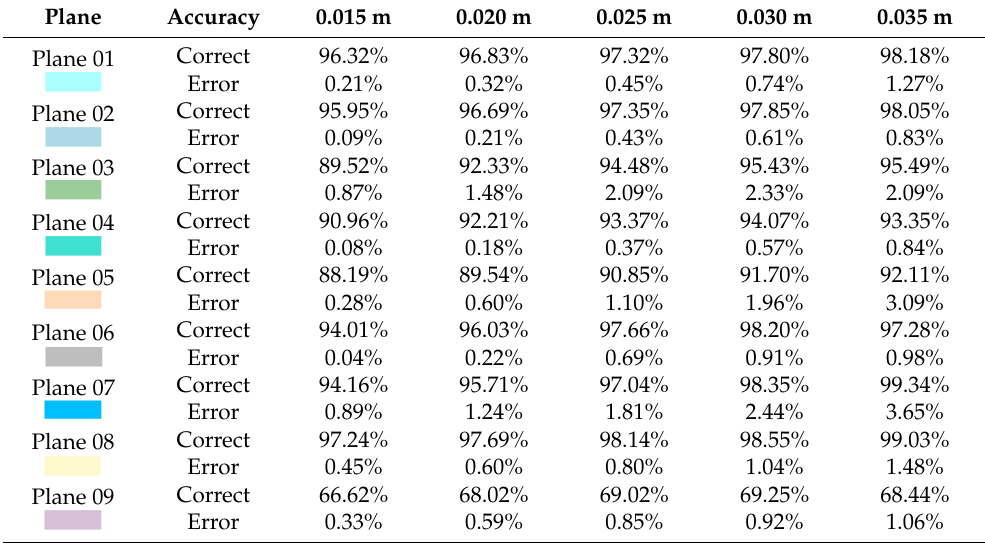
Table 2. Accuracy assessment of pantry’s plane segmentation using the proposed method under different distance thresholds.